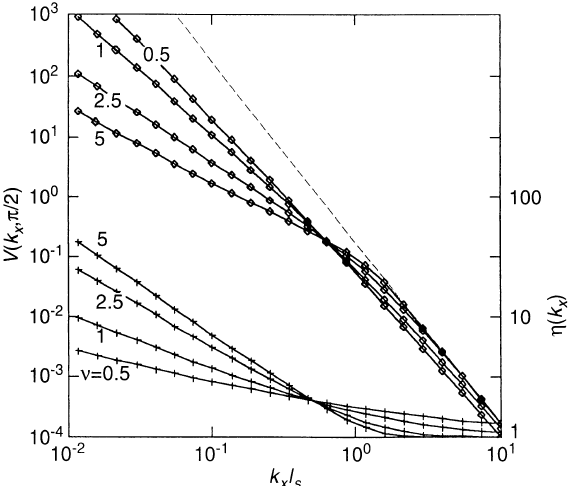
Fig. 4. The 1D horizontal spectra V (cid:133) k x ; (cid:112) = 2 (cid:134) of LASIs ( diamonds ) and the 1D spectrum V is (cid:133) k x (cid:134) of LI inhomogeneities ( dashed line ) with the same GE spectrum